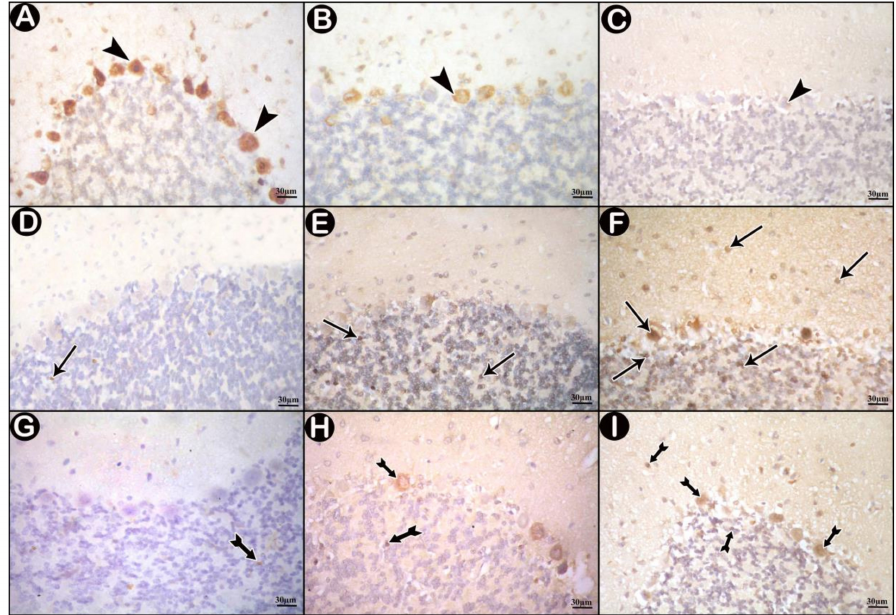
Figure 5. Immunohistochemically stained sections in cerebellar cortex of the study groups. ( A , D , G ) control group. ( B , E , H ) low- dose group. ( C , F , I ) high-dose group. ( A – C ) immune reactions for Calbindin D28k (CB) (arrow head). ( D – F ) c-Jun N-terminal kinase (JNK) immune-reactions (arrows). ( G – I ) nuclear factor kappa beta (NF- κ B) immune reactions (tailed